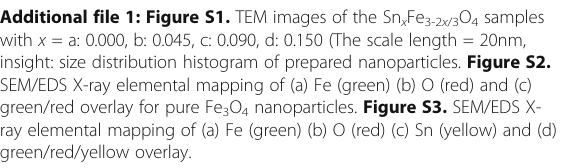
Additional file 1: Figure S1. TEM images of the Sn x Fe 3-2 x /3 O 4 samples with x = a: 0.000, b: 0.045, c: 0.090, d: 0.150 (The scale length = 20nm, insight: size distribution histogram of prepared nanoparticles. Figure S2. SEM/EDS X-ray elemental mapping of (a) Fe (green) (b) O (red) and (c) green/red overlay for pure Fe 3 O 4 nanoparticles. Figure S3. SEM/EDS X- ray elemental mapping of (a) Fe (green) (b) O (red) (c) Sn (yellow) and (d) green/red/yellow overlay.